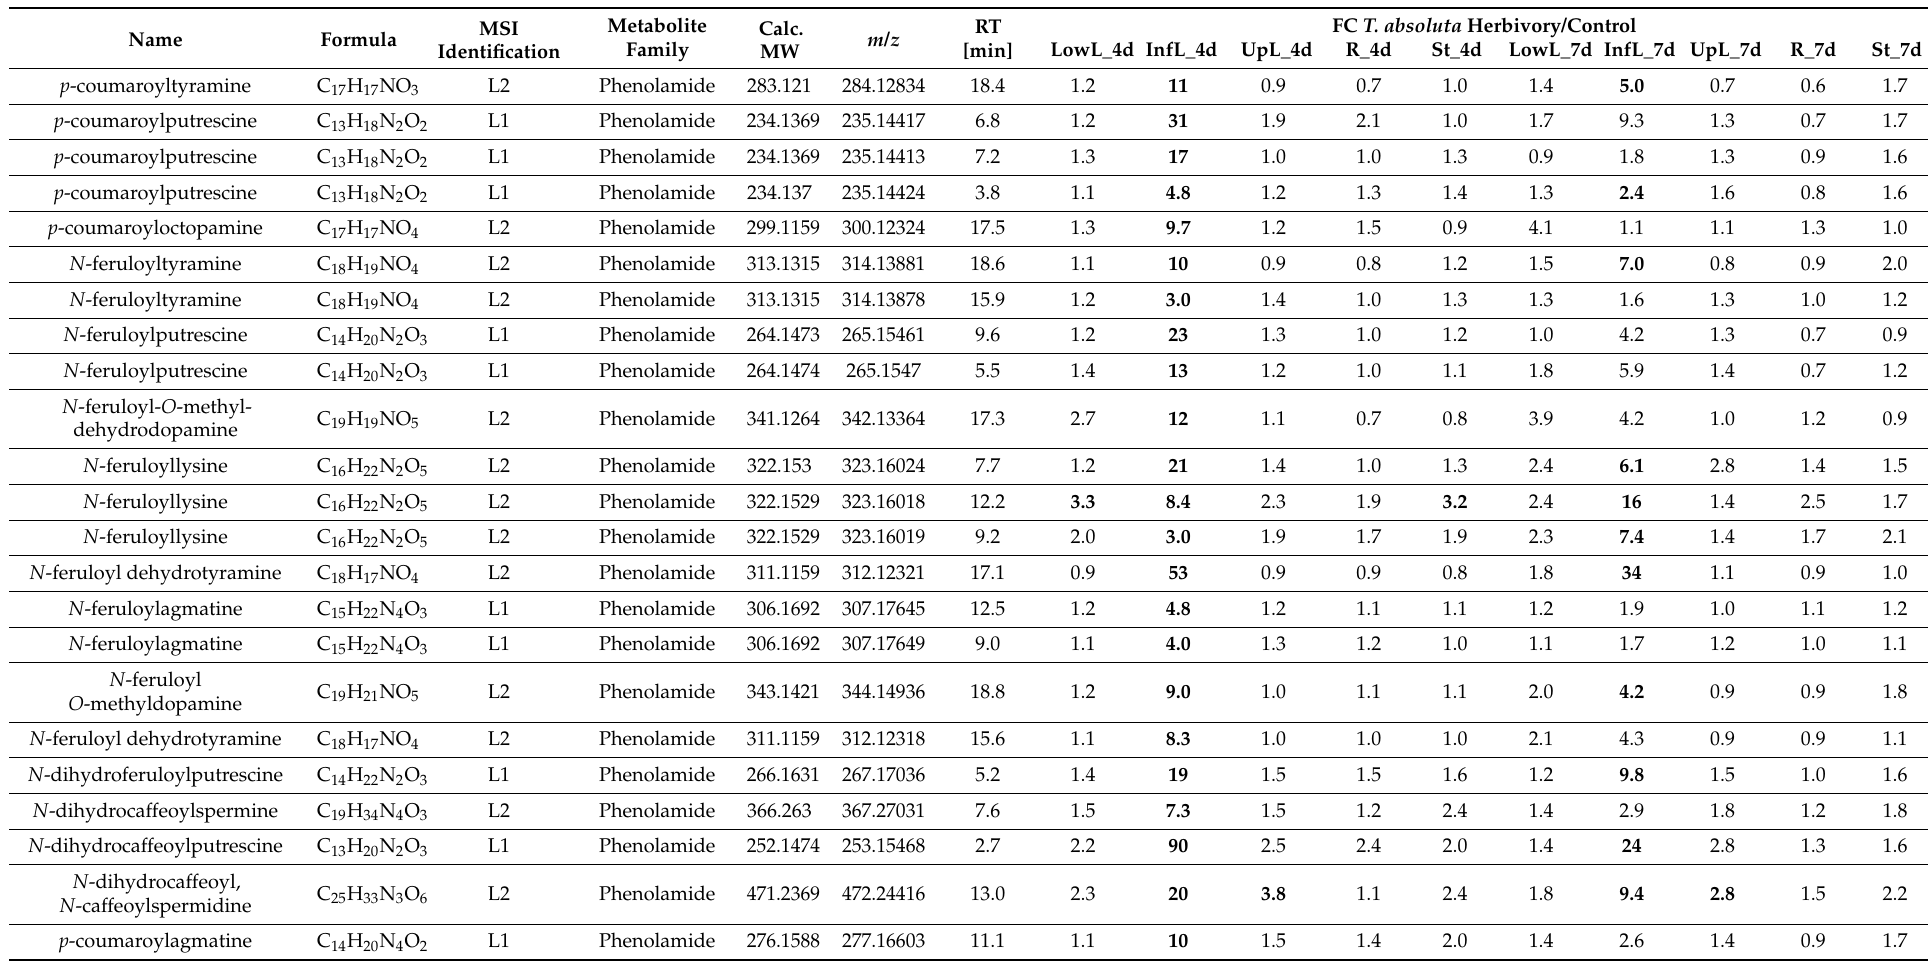
Table 1. List of annotated metabolites whose accumulation is impacted by the herbivory of T. absoluta . The identification followed the Metabolomics Standard Initiative (MSI) notation [27]. For each metabolite, the foldchange (FC) of the base peak intensity from herbivory treated vs. control was calculated in each organ class and harvest. Statistically significant FC are in bold. Metabolite name followed by an asterisk (*) indicated metabolites presented solely in the T. absoluta infested leaf, meaning they could be specific to the presence of the